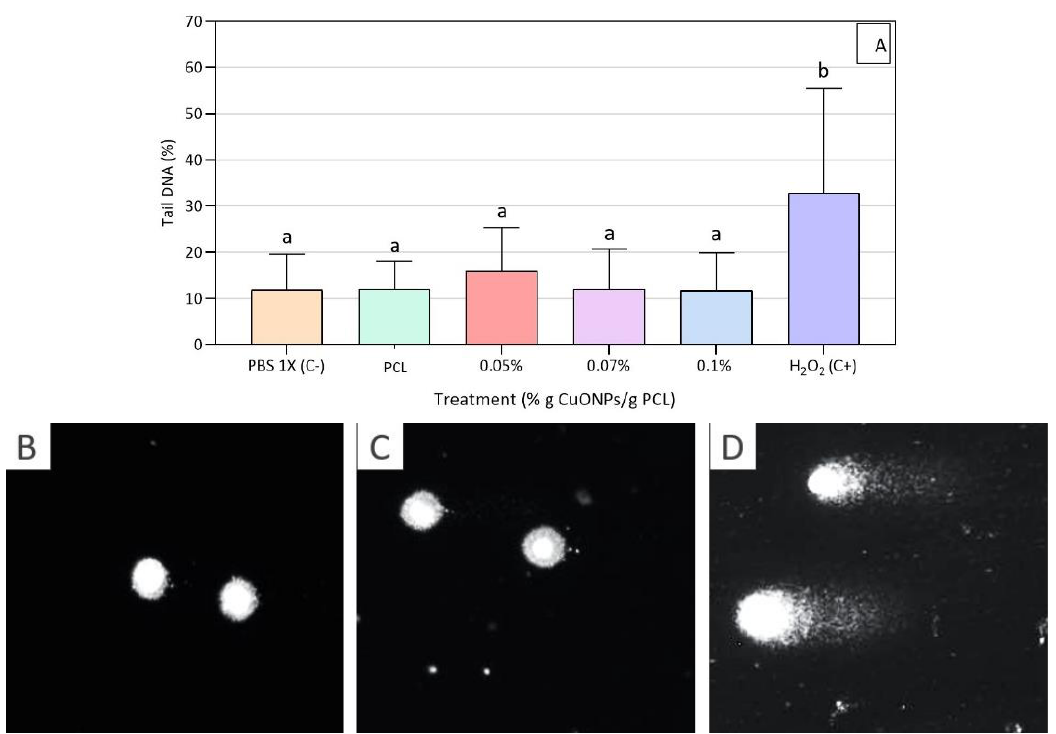
Figure 7. Genotoxicity results for HFF-1 cells exposed to neat PCL and active PCL films. ( A ): Genotoxicity assay on HFF-1 cells after 3 h of exposure to the active extracts, ( B ): HFF-1 cells with PCL + 0.07% CuONPs’ extract, ( C ): HFF-1 cells with DMEM, ( D ): HFF-1 cells with H 2 O 2 (80 µ M in PBS 1X). Mean values with di ff erent letters represent significant di ff erences ( p < 0.05) among the samples as determined with a one-way analysis of variance (ANOVA) and Tukey’s multiple comparison tests.